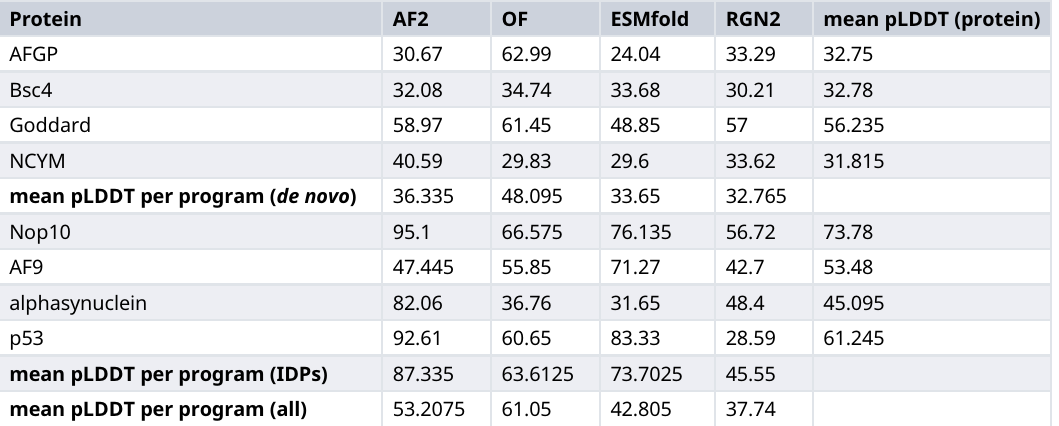
Table 2. mean pLDDT for each structure predictor of each protein.